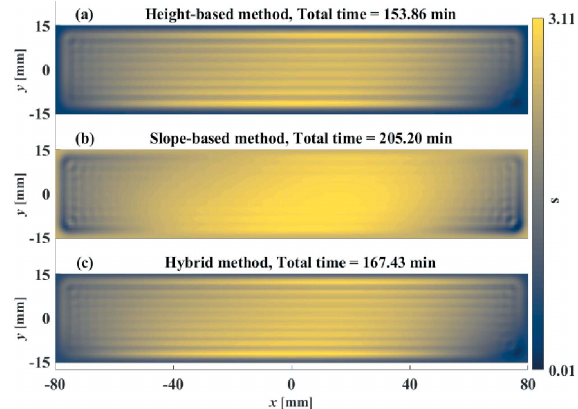
Figure 6 Dwell time optimized from the height-based method ( a ), slope-based method ( b ) and hybrid method ( c